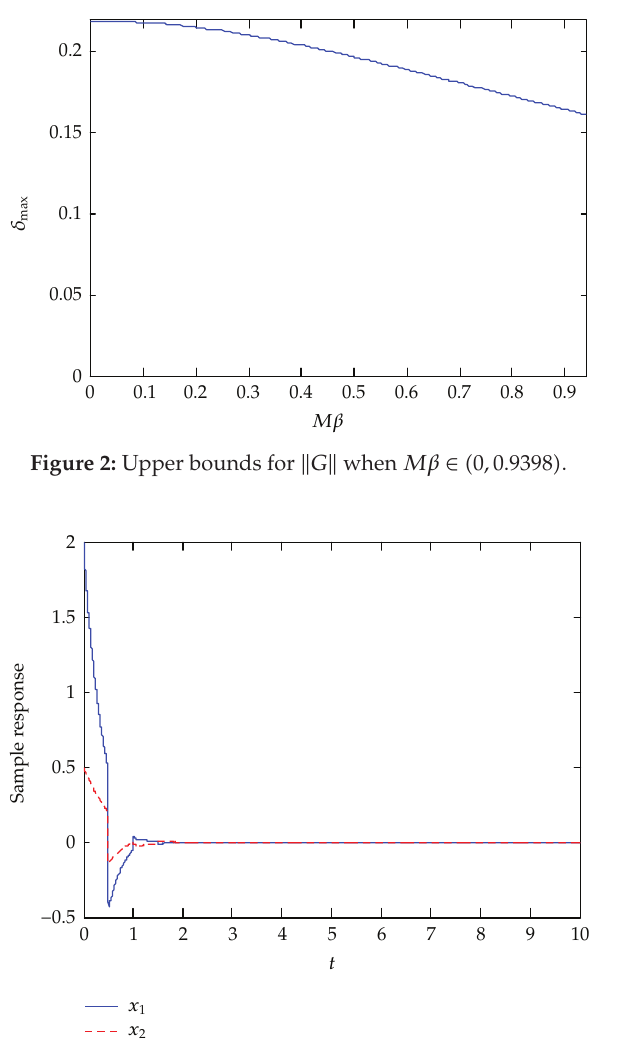
Figure 3: Sample response of PWM feedback system (cid:2) 3.3 (cid:3) in Example